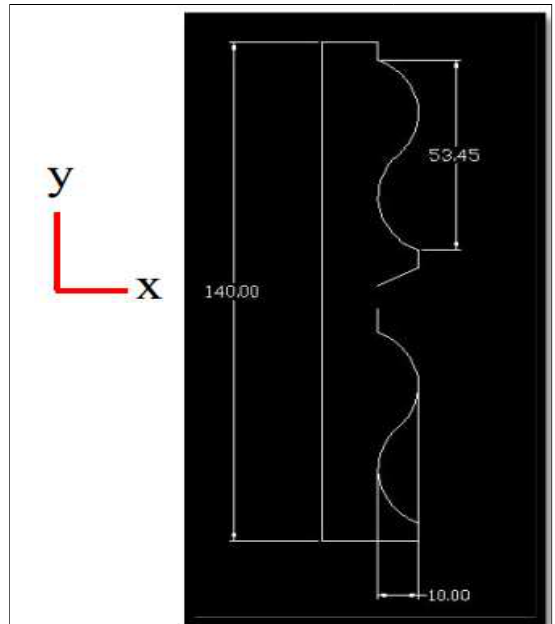
Fig. 2. Shown the dimension of the form.